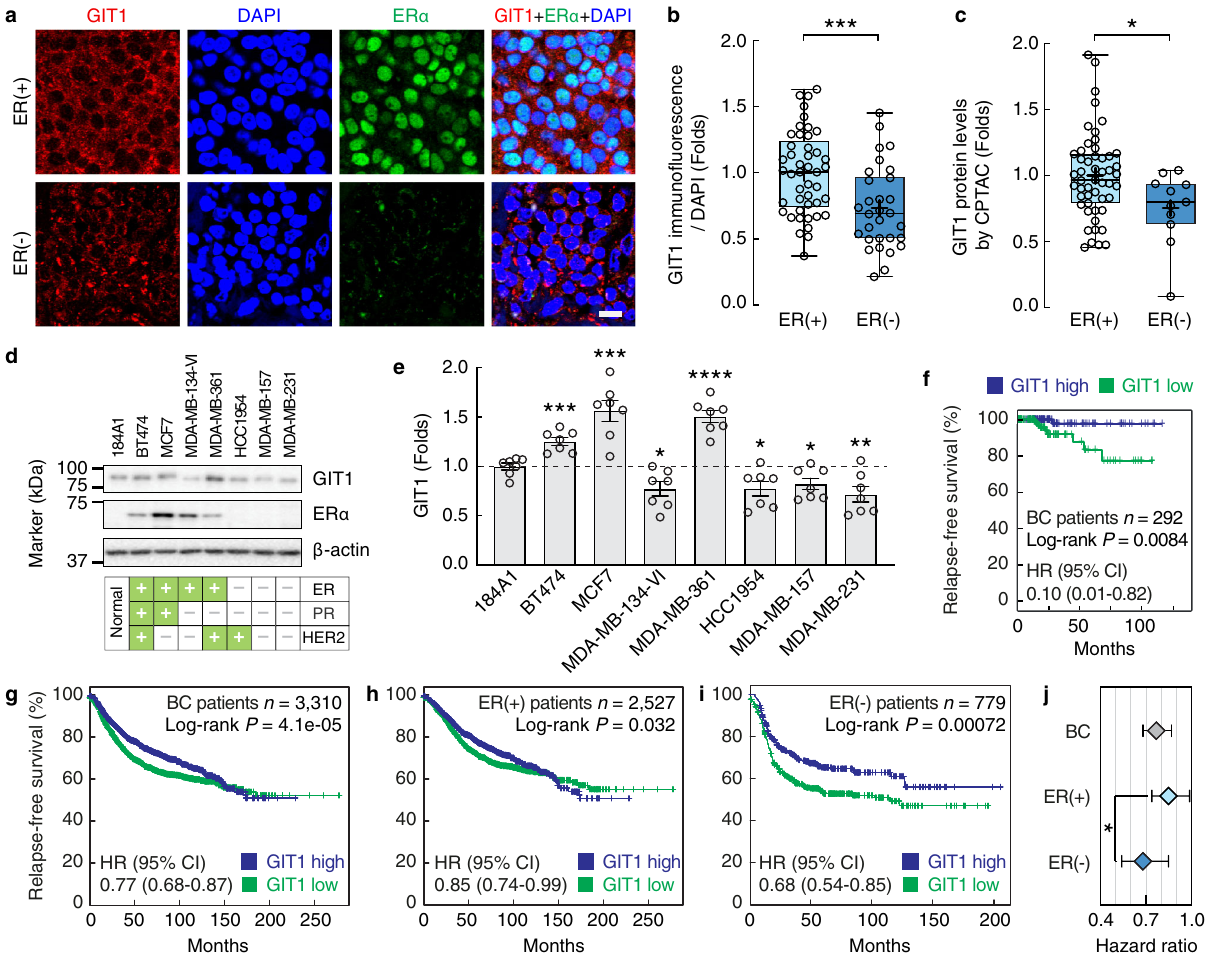
Fig. 1 Downregulated GIT1 expression in ER( − ) breast tumours is associated with poor relapse-free survival in patients. a , b Immunostaining of GIT1 and ER α in one ER( + ) and one ER( − ) patient breast tumour section ( a ) and the quantitative analysis of GIT1 immuno fl uorescence relative to DAPI ( b ; ER( + ) ( n = 45) versus ER( − ) ( n = 30), P = 0.0006, t test). Scale bar, 10 μ m. c Mass spectrometry data from CPTAC of the GIT1 protein levels in ER( + ) and ER( − ) patients (ER( + ) ( n = 51) versus ER( − ) ( n = 11), P = 0.024, t test). d , e , Western blots of GIT1 in various human breast cancer cells ( d ) and the quantitative analysis ( e ; n = 7 independent biological replicates, 184A1 versus BT474, P = 0.0004; MCF7, P = 0.0003; MDA-MB-134-VI, P = 0.015; MDA- MB-361, P < 0.0001; HCC1954, P = 0.017; MDA-MB-157, P = 0.023; MDA-MB-231, P = 0.0067; t tests). ER, oestrogen receptor. PR, progesterone receptor. HER2, human epidermal growth factor receptor 2. f Kaplan – Meier plot of relapse-free survival of the breast cancer patients from the TCGA database 59 strati fi ed by GIT1 expression ( n = 292, P = 0.0084, log-rank test). g – i Kaplan – Meier plots of relapse-free survival of all breast cancer (BC) patients ( g ; n = 3,310, P < 0.0001, log-rank test), ER( + ) patients ( h ; n = 2527, P = 0.032, log-rank test), and ER( − ) patients ( i ; n = 779, P = 0.0007, log- rank test) from KM-plotter 61 strati fi ed by GIT1 expression. Hazard ratios (HRs) and their 95% con fi dence intervals (95%CI) are indicated. j , Forest plot of HRs for survival analysis of all BC, ER( + ), and ER( − ) patients strati fi ed by GIT1 expression (ER( + ) ( n = 2527) versus ER( − ) ( n = 779), P = 0.047, one- sided unpaired t test). Error bars show 95%CI. All data are shown as the mean ± s.e.m. For the box plots, the centre line shows the median, the plus sign shows the mean, the upper and lower boundaries of the box show the upper and lower quartiles, and the whiskers show the minimum and maximum values. * P < 0.05, ** P < 0.01, *** P < 0.001, **** P < 0.0001 by two-sided unpaired t tests. Source data are provided as a Source Data fi